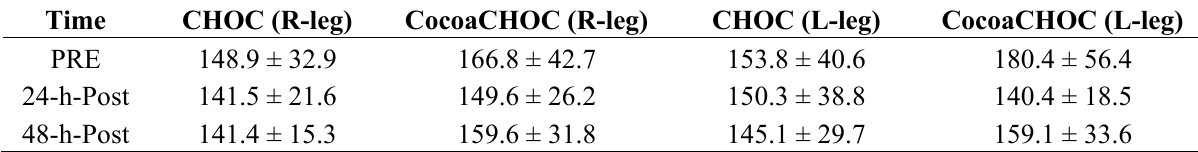
Table 3. Isometric force over time between treatments (Nm) ( n =